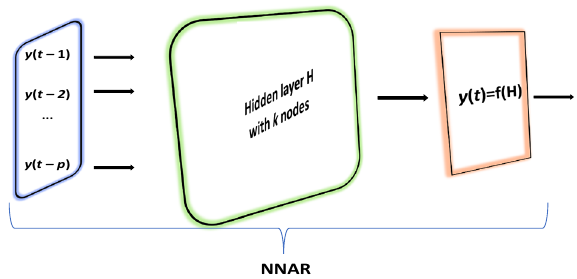
Figure 4. The architecture of a feed-forward neural network autoregression model (NNAR) with p lagged inputs, k nodes in the hidden layer and the activation function f